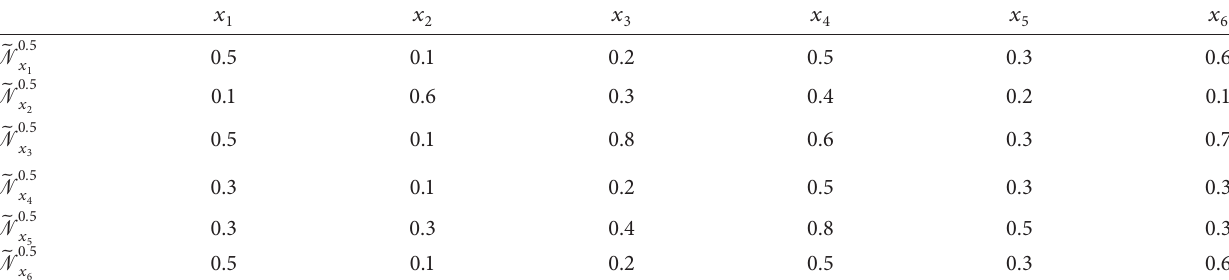
Table 3: Fuzzy β -neighborhood of 􏽥 Γ .